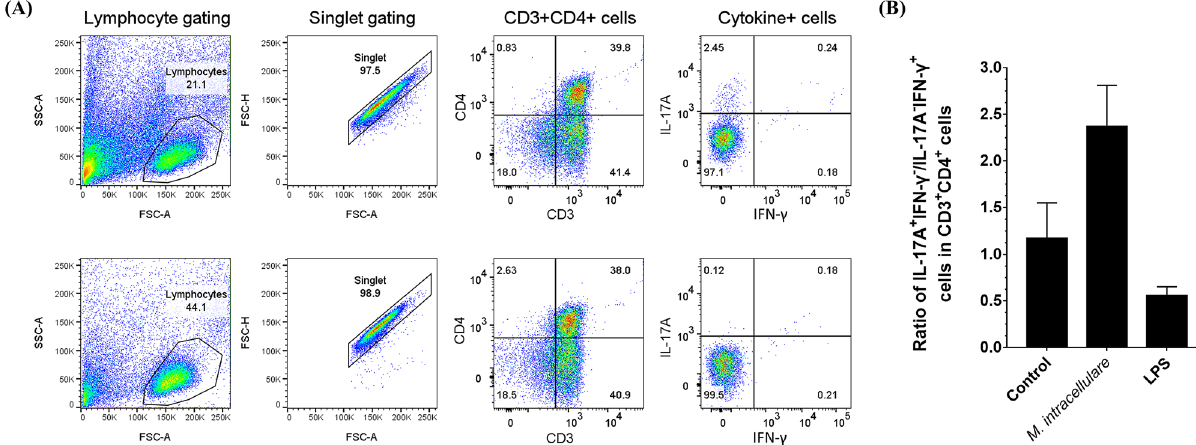
Figure 7. IL-17- and IFN-γ-producing cells among canine CD4 + T cells in response to M. intracellulare . ( A ) Example of the flow cytometry gating strategy of IL-17- or IFN-γ- producing canine CD4 + T cells co-cultured with M. intracellulare -infected MDMs for 5 days (upper row) or noninfected MDMs (lower row). ( B ) Bar graph presenting the ratio of the proportion of IL-17-producing CD4 + T cells to IFN-γ-producing CD4 + T cells. Monocyte-depleted PBMCs were co-cultured with noninfected (control), M. intracellulare -infected, or LPS- stimulated MDMs. Each bar presents the mean ± SEM from five